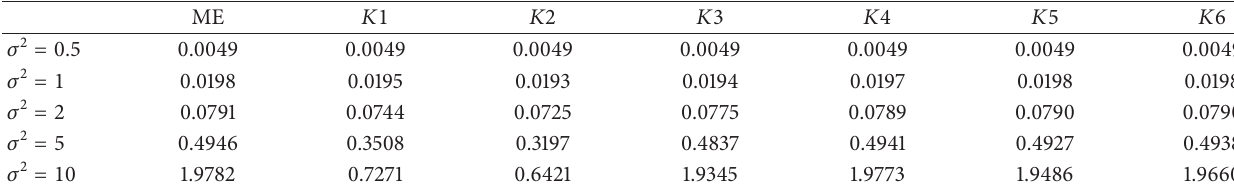
Table 12: Estimated MSE with 𝑛 = 150 , 𝑝 = 4 , and 𝛾 = 0.99 .